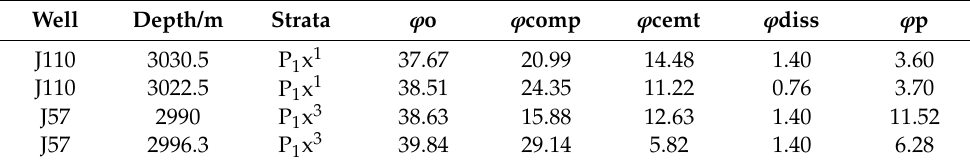
Table 2. The porosity evolution of the Lower Shihezi Formation